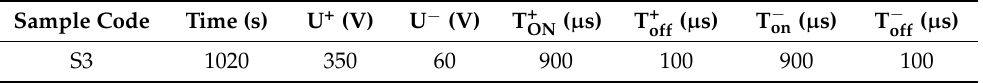
Table 3. PEO process parameters for Ti6Al4V alloy without